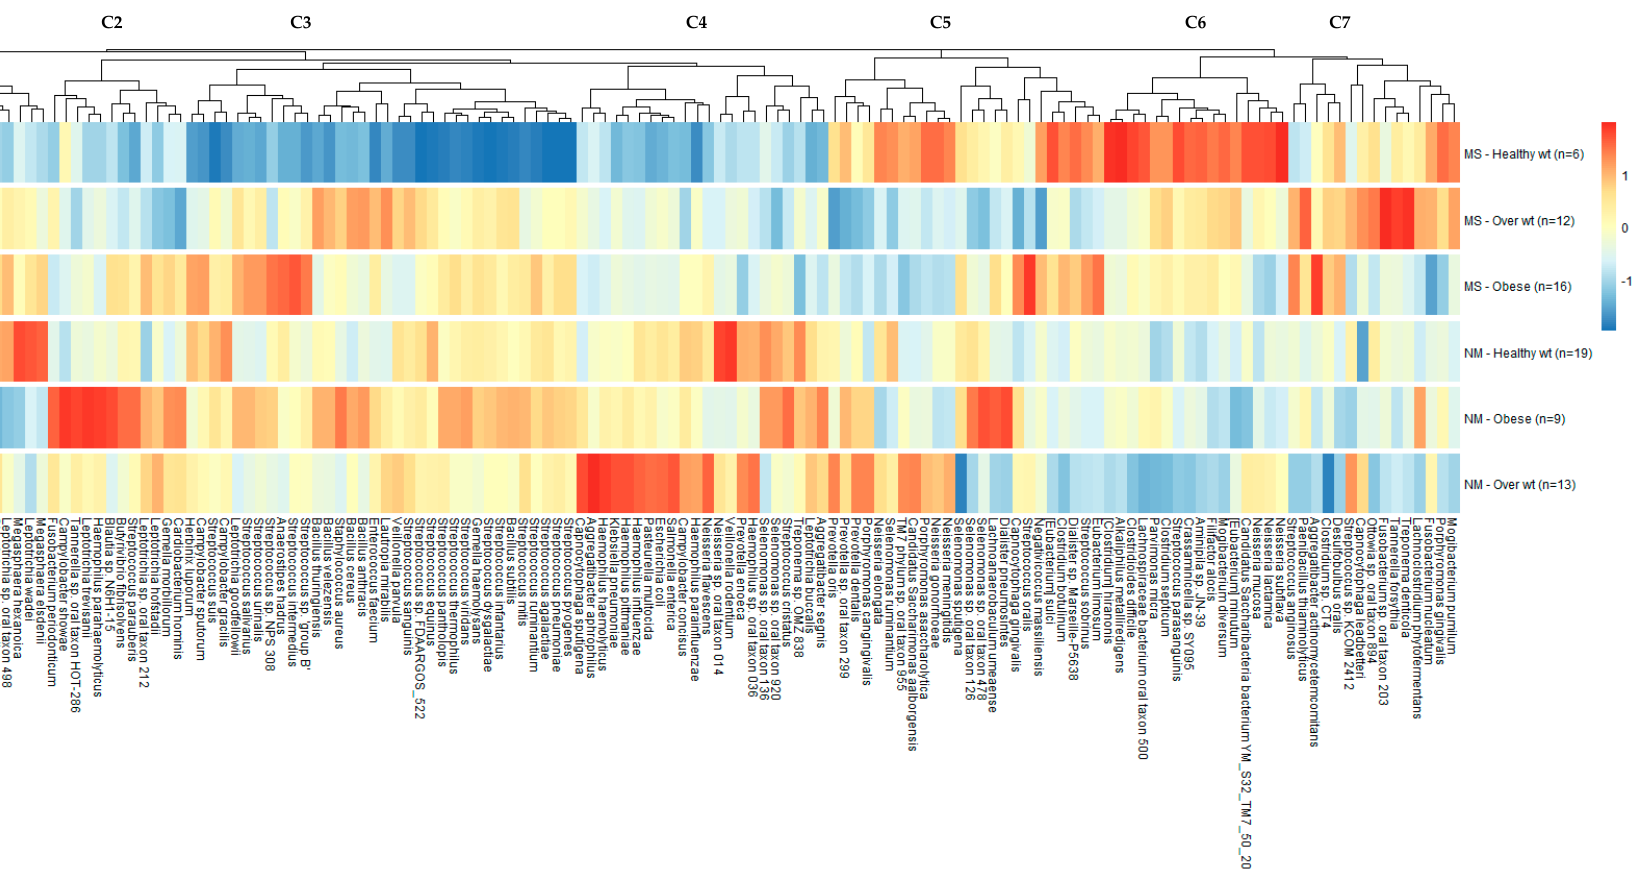
Figure 8. Heatmap showing the distribution of different species (relative abundance > 0.1%) grouped by BMI and periodontal condition. Relative abundances of species were ranked based on group counts (scaled across columns). The number of participants in each group is also shown. Red indicates high abundance in a particular group and blue indicates low abundance. Dendrograms show clustering based on the relative abundance of different species (left dendrogram: group clustering; top dendrogram: clustering of species based on abundances in different groups).